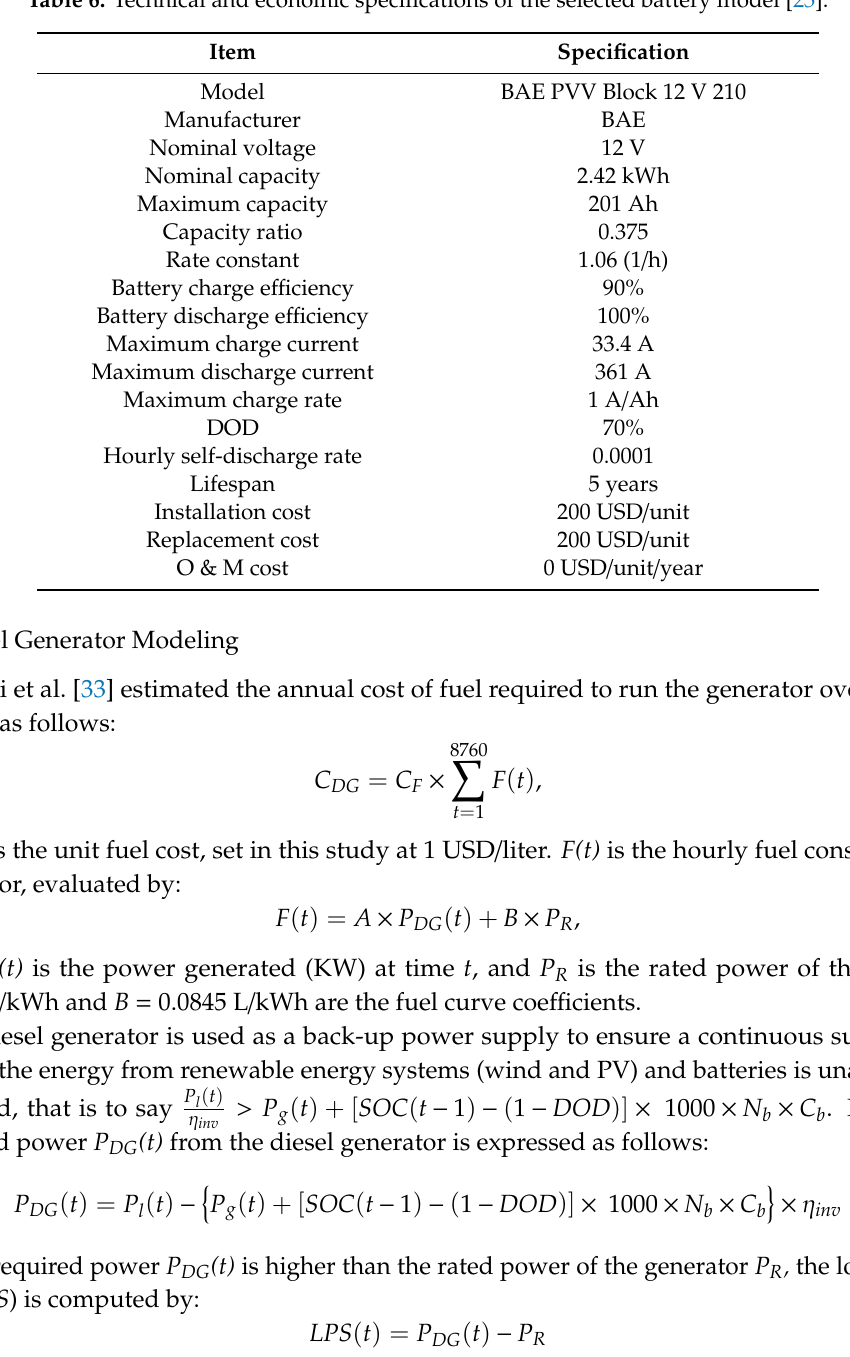
Table 6. Technical and economic specifications of the selected battery model